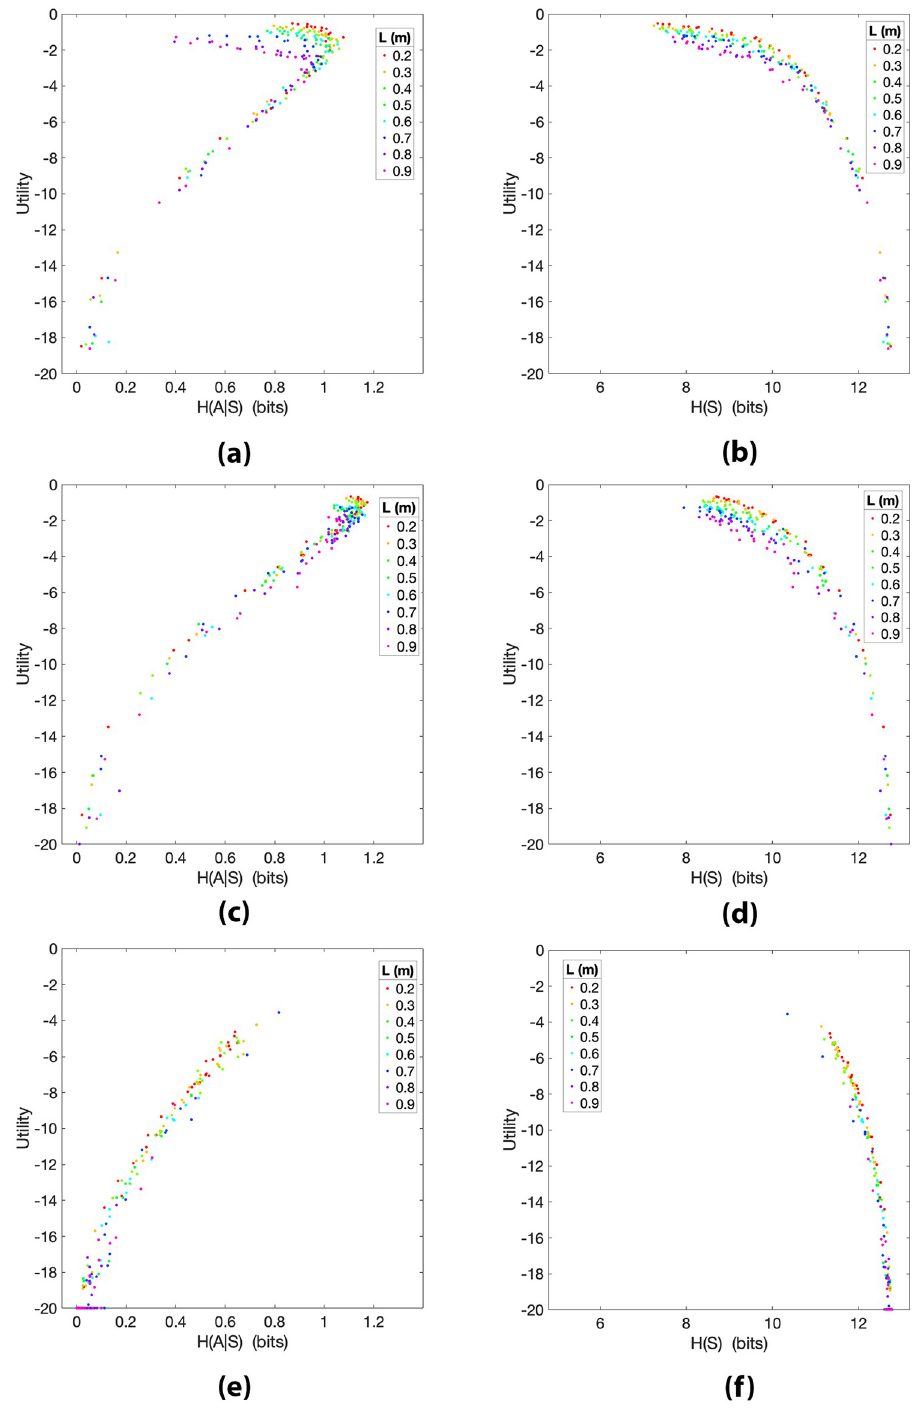
Fig 12. Utility U j of simulations j plotted as a function of H ( A j | S j ) ((a,c,e)) and H ( S j ) ((b,d,f)) for all pendulum lengths L and artificial controllers with different observation disturbances η (here σ T standard deviations s O − 0.951 ( p < 0.01). (c) s O ¼ 0 : 2 ; ρ = − 0.908 ( p < 0.01). (e) s O s O _ y